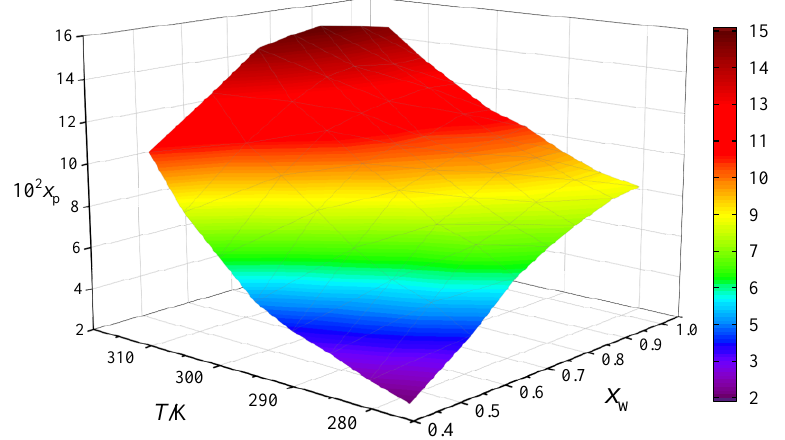
Figure 8. Mole fraction solubility of 1,5-pentanediamine adipate dihydrate in (water + ethanol) mixed solvents with different mole fractions at various temperatures.